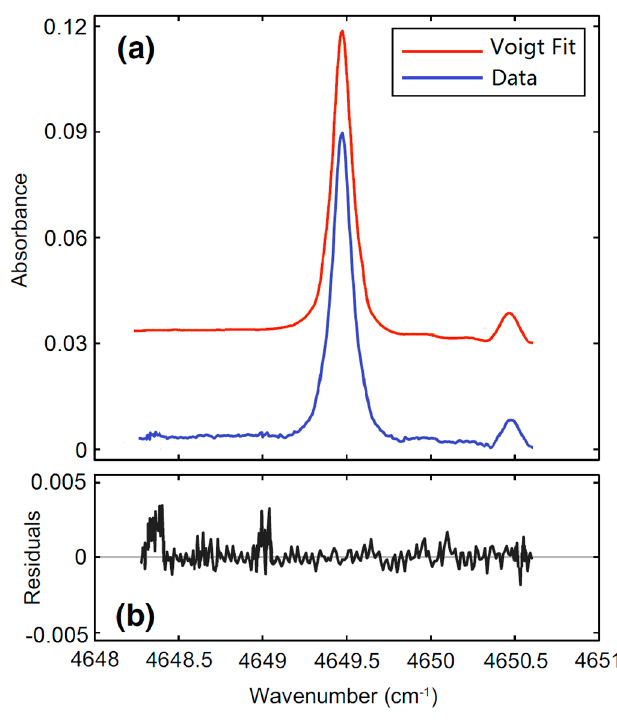
Figure 5. ( a ) Measured absorption spectrum (blue line) and Voigt theoretical spectrum (red line) via the LOP-DAST method. ( b ) Residual curve calculated by aforementioned two spectrums.